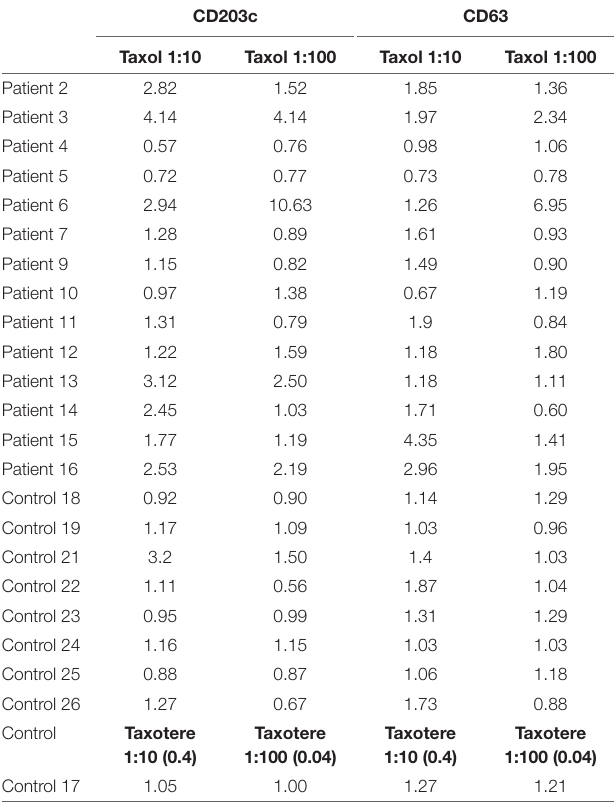
TABLE 3 | Stimulation index from the CD63 and CD203c expression of patients and healthy controls after stimulation with paclitaxel or docetaxel vs. PBS (negative